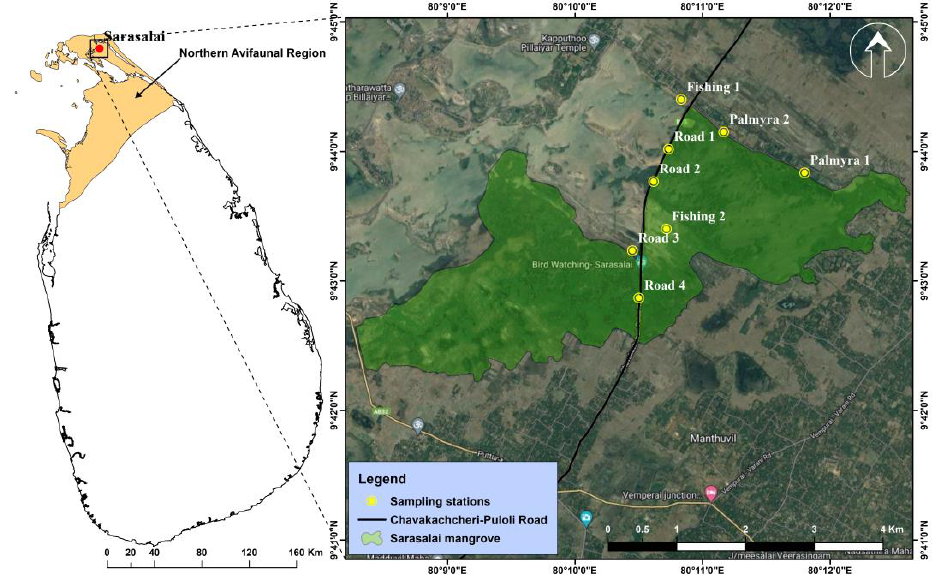
Figure 1. Sarasalai proposed mangrove showing the eight sampling stations.